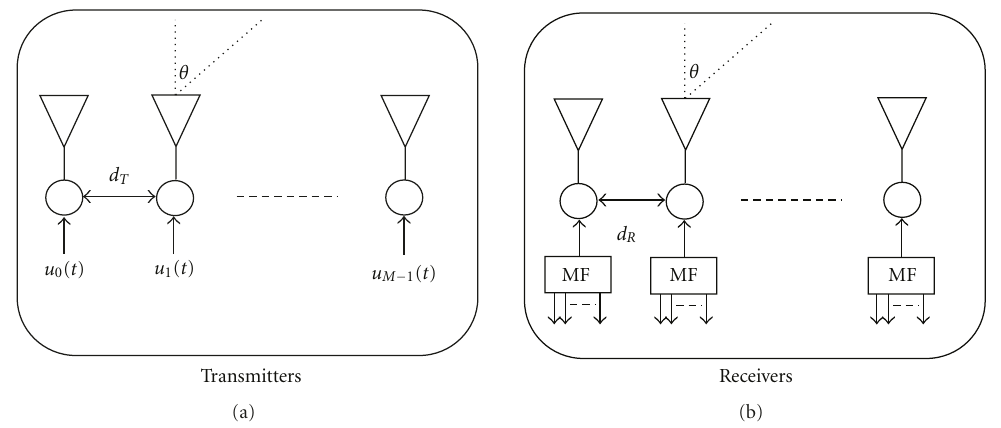
Figure 1: Transmitters and receivers in a MIMO radar (MF = Matched